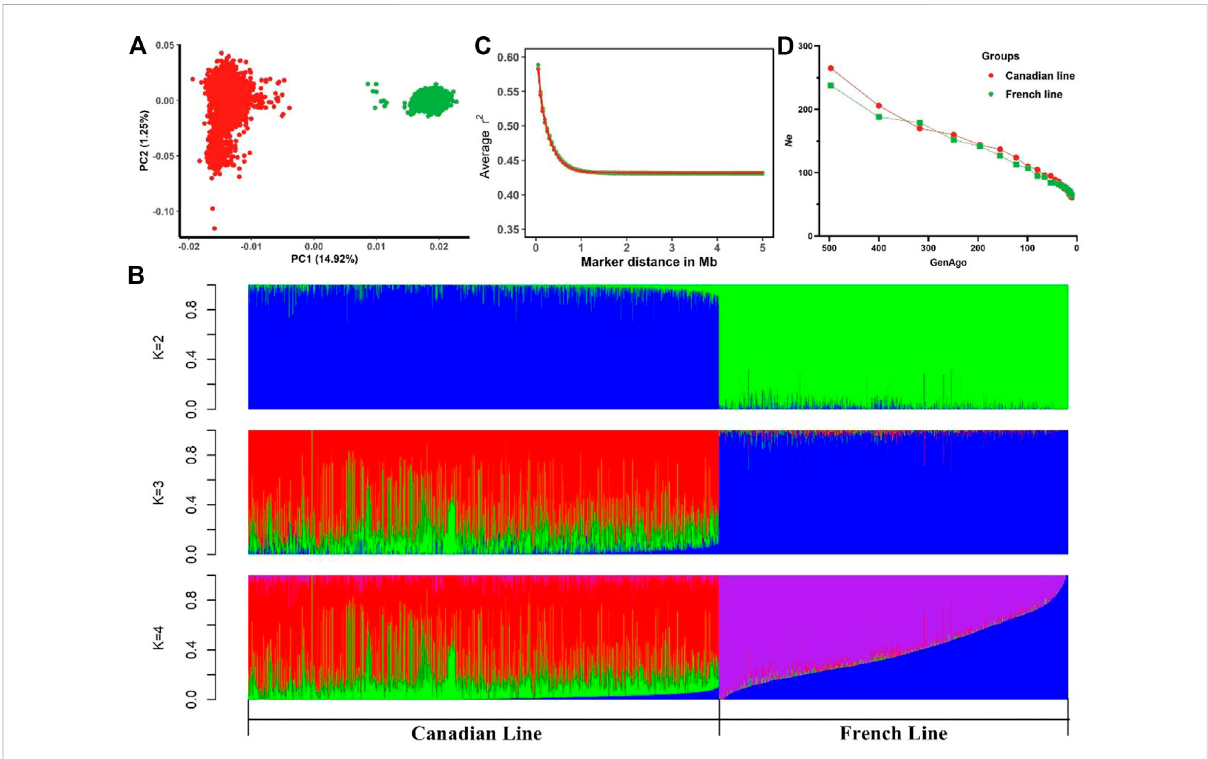
FIGURE 1 Descriptive statistics of population structure. (A) Principal component analysis indicating the relationship between the fi rst two principal components (PC1, PC2) and the proportions of genetic variances explained (% explained var.) among Canadian and French pig lines. (B) Admixture analysis for Canadian and French lines ranging from K = 2 to K = 4. (C) Linkage disequilibrium (LD) for the Canadian and French lines, r 2 values were averaged within bins of 0.5 Mb between pair-wise SNP physical distance and pooled over autosomes. (D) Average estimated effective population size ( Ne ) plotted against the number of past 500